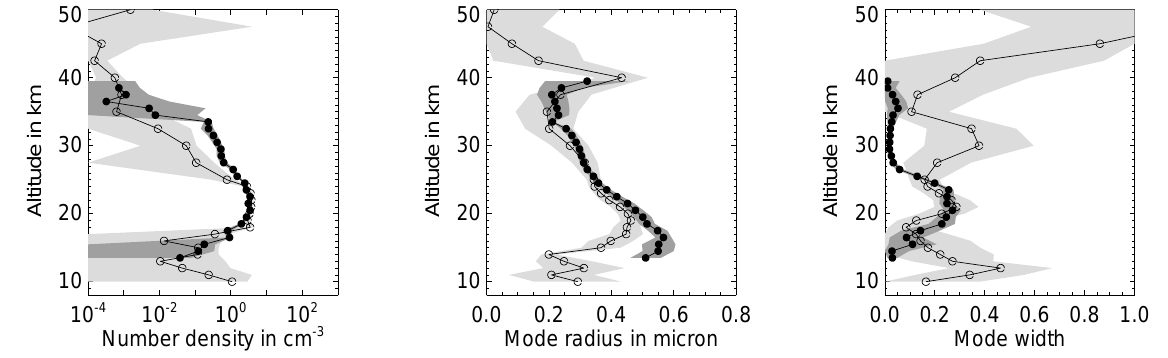
Fig. 5. Comparison of mean vertical profiles for aerosol parameters obtained from this work ( • ; error range in dark grey ) and from ORA ( ◦ ; error range in light grey ) ; the average is weighted by the error found on the parameters, and concerns the time period August 1992 – May 1993 and the latitude interval [10 ◦ N–20 ◦